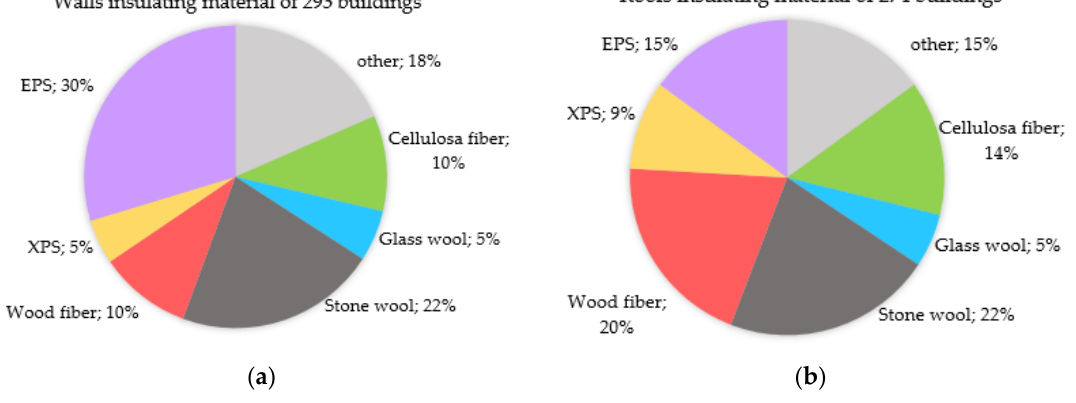
Figure 9. Share of insulating materials used in walls ( a ) and roofs ( b ). Note: the charts include the buildings according to the collected information.